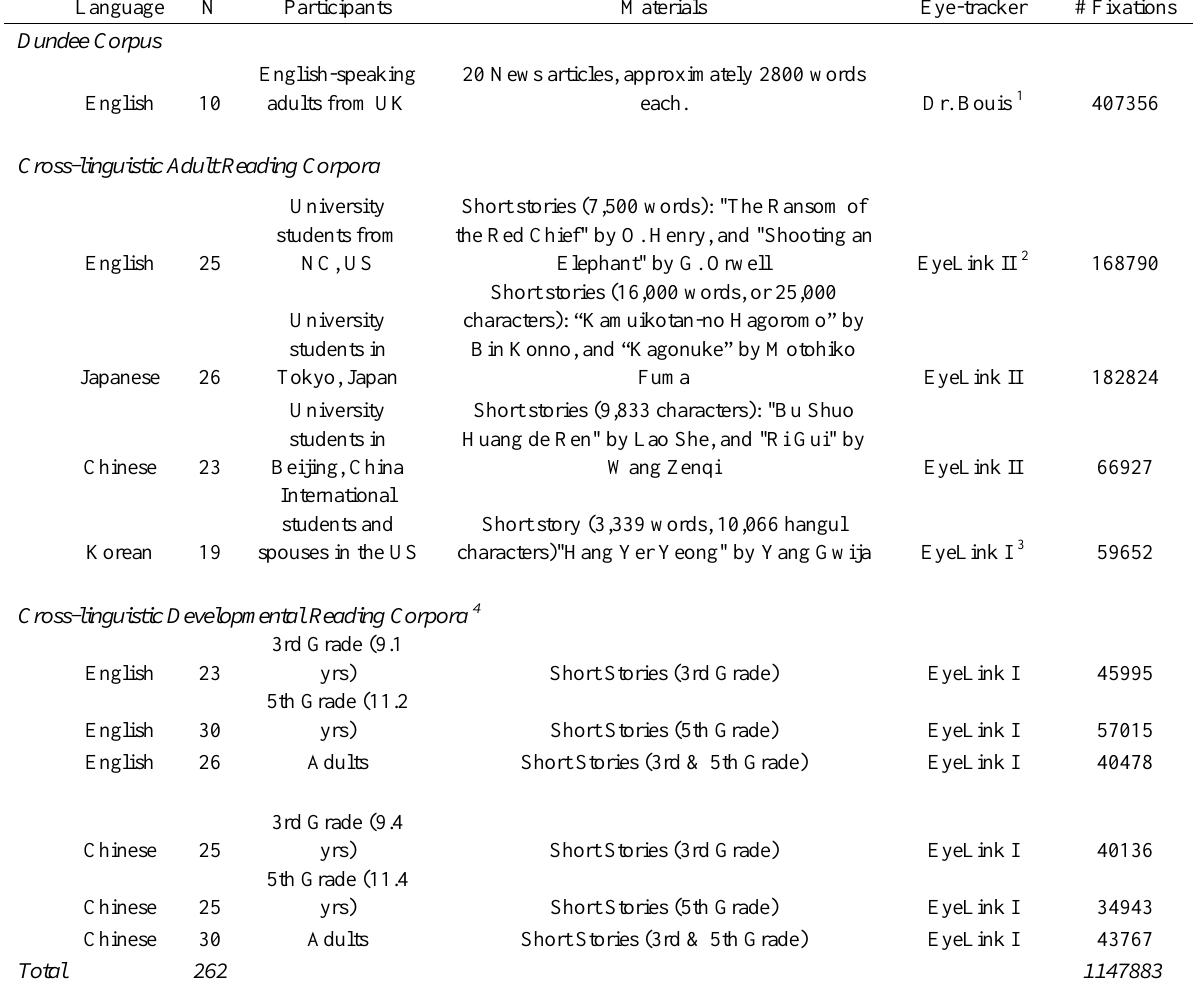
Table 1 Summary of characteristics of the datasets used in the